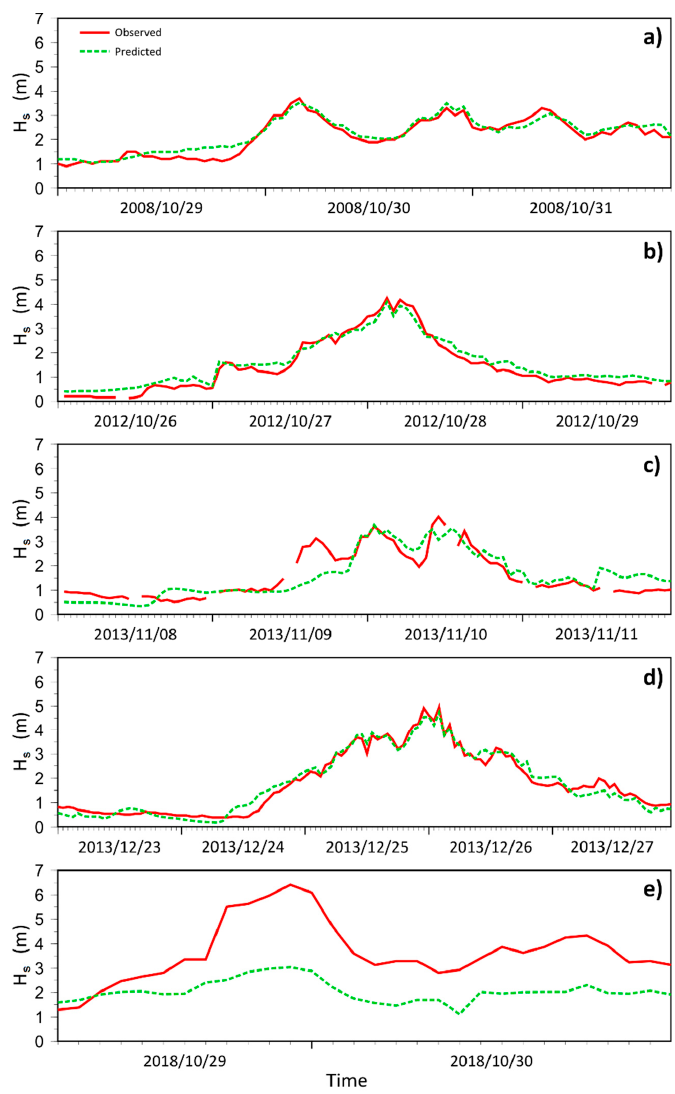
Figure 3. Comparison between the significant sea wave heights (H s ) measured by the buoys (red lines) and those estimated using microseism recordings (green dotted lines) during the five considered sea storm events: ( a ) October 2008; ( b ) October 2012; ( c ) November 2013; ( d ) December 2013; ( e ) October 2018. The time window considered is not the same for all sea storms due to lack of data.